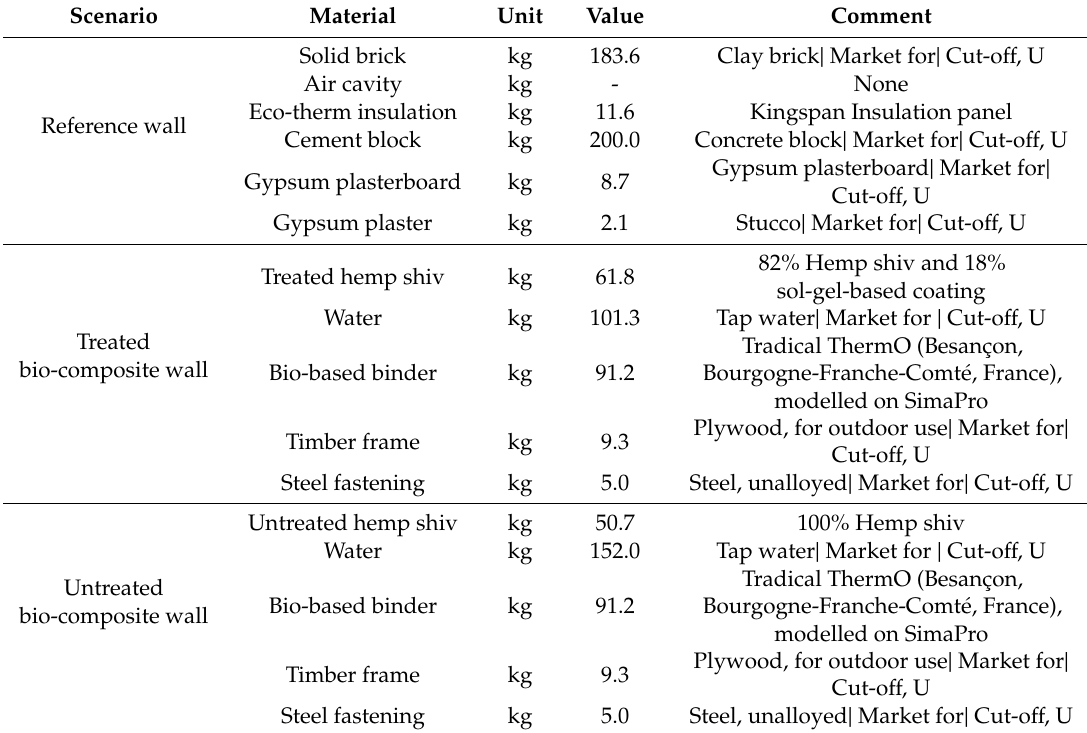
Table 3. Characteristics of one m 2 of walls and materials